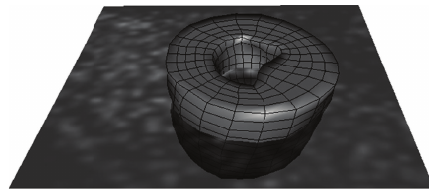
Figure 1: Finite element mesh of Heart 1 at the end-systolic state of the analysis superimposed on the end-systolic PET image. The FE LV model has 3366 nodes and 2712